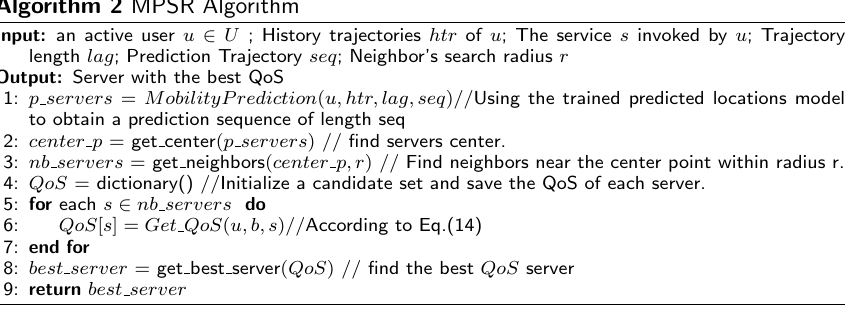
Algorithm 2 MPSR